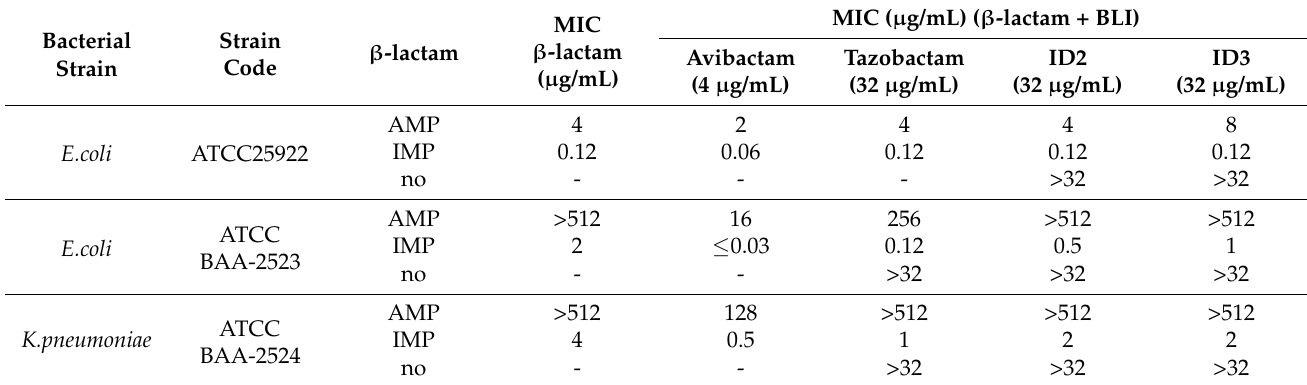
Table 6. Antibacterial activity of AMP and IMP in combination with ID2 and ID3 .